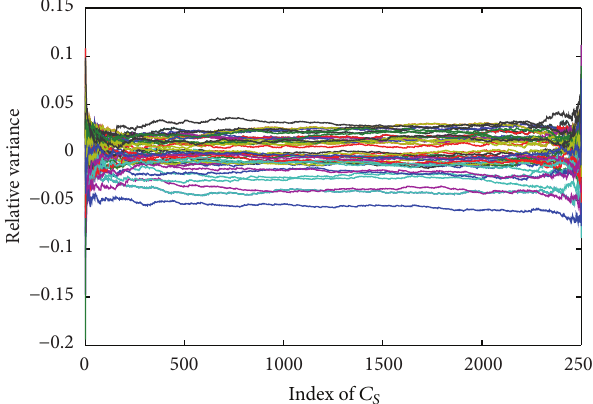
Figure 2: Relative deviations of subgraph centralities 𝐶 𝑆 (𝑖) of the ER